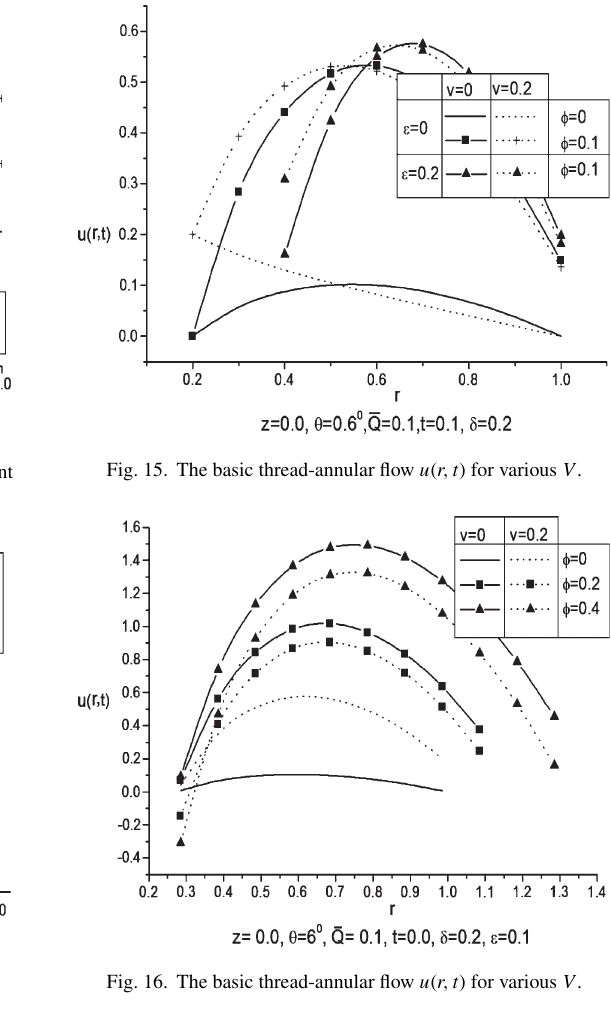
Fig. 13. The basic thread-annular flow u ( r,t ) for various Q .